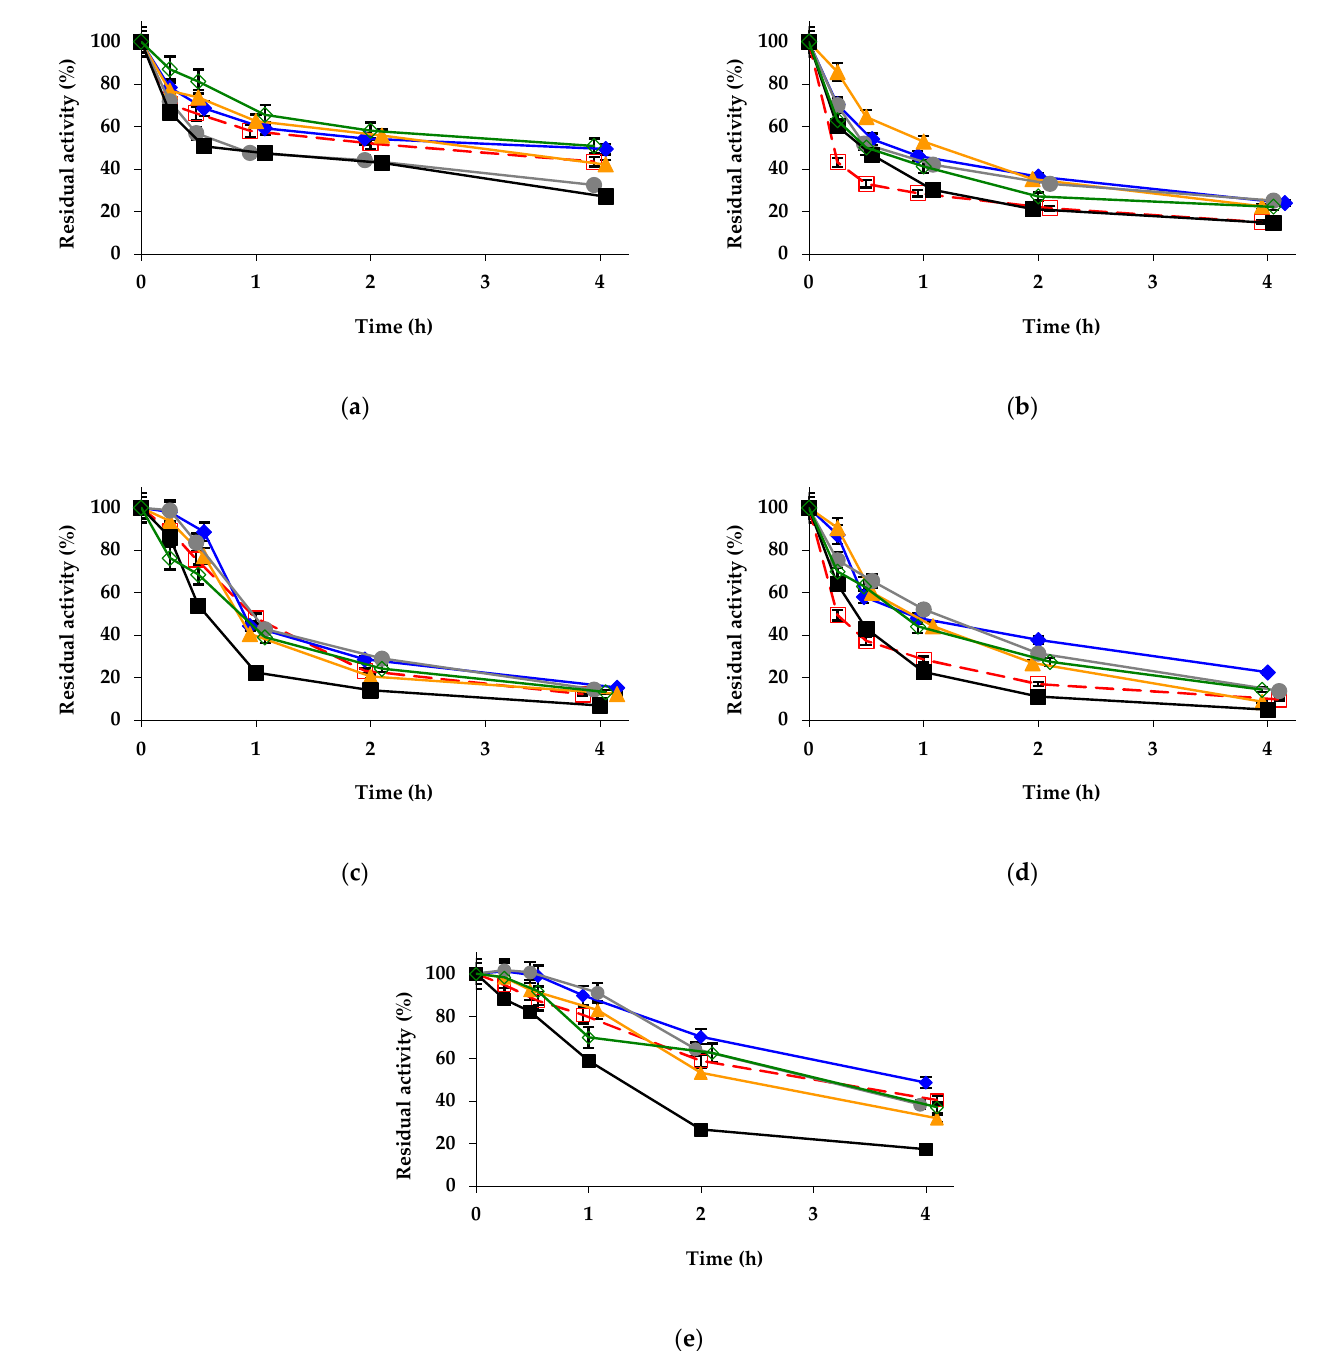
Figure 6. Inactivation courses of different octyl-CALB biocatalysts modified with ( a ) 1% glutaraldehyde, ( b ) amination using 2 M ethylenediamine, ( c ) 1 mM picrylsulfonic acid, ( d ) 10% polyethylenimine, and ( e ) 10% dextran sulfate. The biocatalysts were inactivated at 68 °C ( b ) and 75 °C ( a , c – e ), in presence of 10 mM Tris-HCl buffer at pH 7.0. Other specifications are described in Methods. Unmodified octyl-TLL (empty squares and dashed and red line); octyl-TLL modified with 1% glutaraldehyde (solid rhombus and solid blue line); amination using 2 M ethylenediamine (solid triangles and solid orange line); 1 mM picrylsulfonic acid (solid circles and solid grey line); 10% polyethylenimine (solid squares and solid black line); 10% dextran sulfate (empty rhombus and solid green line).